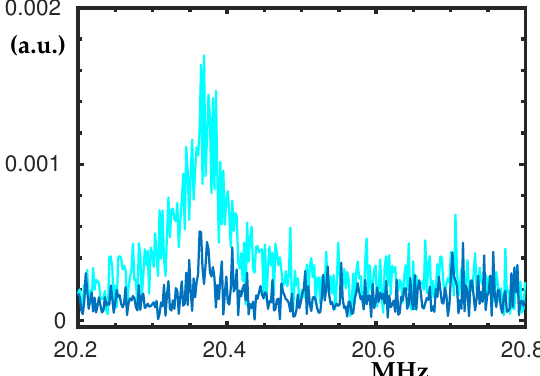
Figure A5. Experimental frequency swipe-up centred at about 20.5 MHz for V pp = 18 V, where the blue and cyan curves denote V of f = 0 V and V of f = 5 V, respectively.